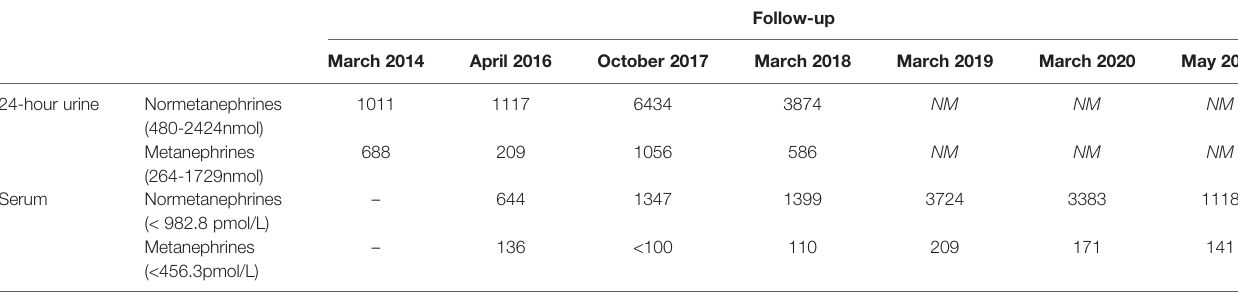
TABLE 4 | Serum and 24-hour urinary metanephrines (reference range), by year of patient